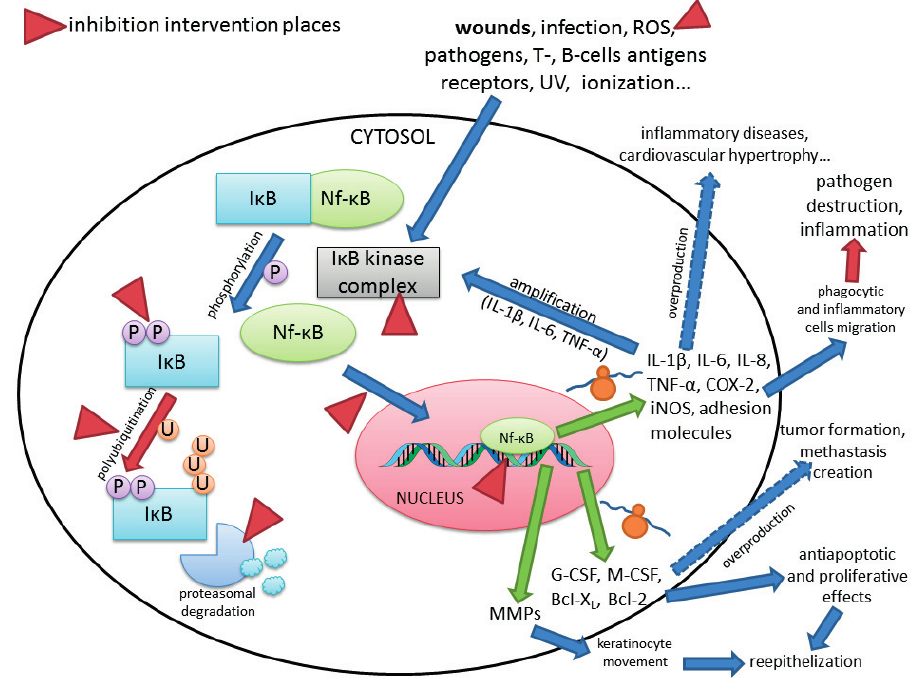
Fig. 3. Classical NF-κB pathway in wound